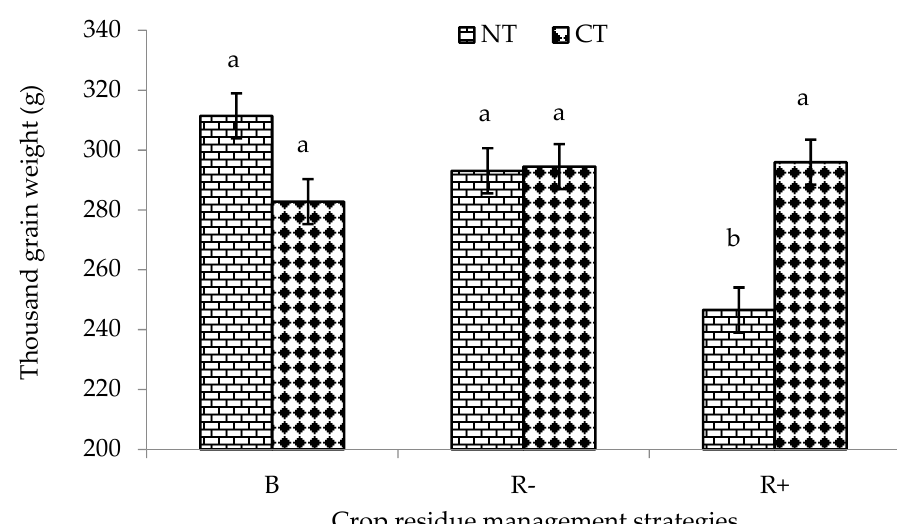
Figure 5. Interactive effects of tillage × crop residue management on the weight of a thousand grains in a maize-based conservation agriculture system in a semiarid climate in South Africa during the 2015/2016 summer season. Different lowercase letters indicate significant differences at p ≤ 0.001.